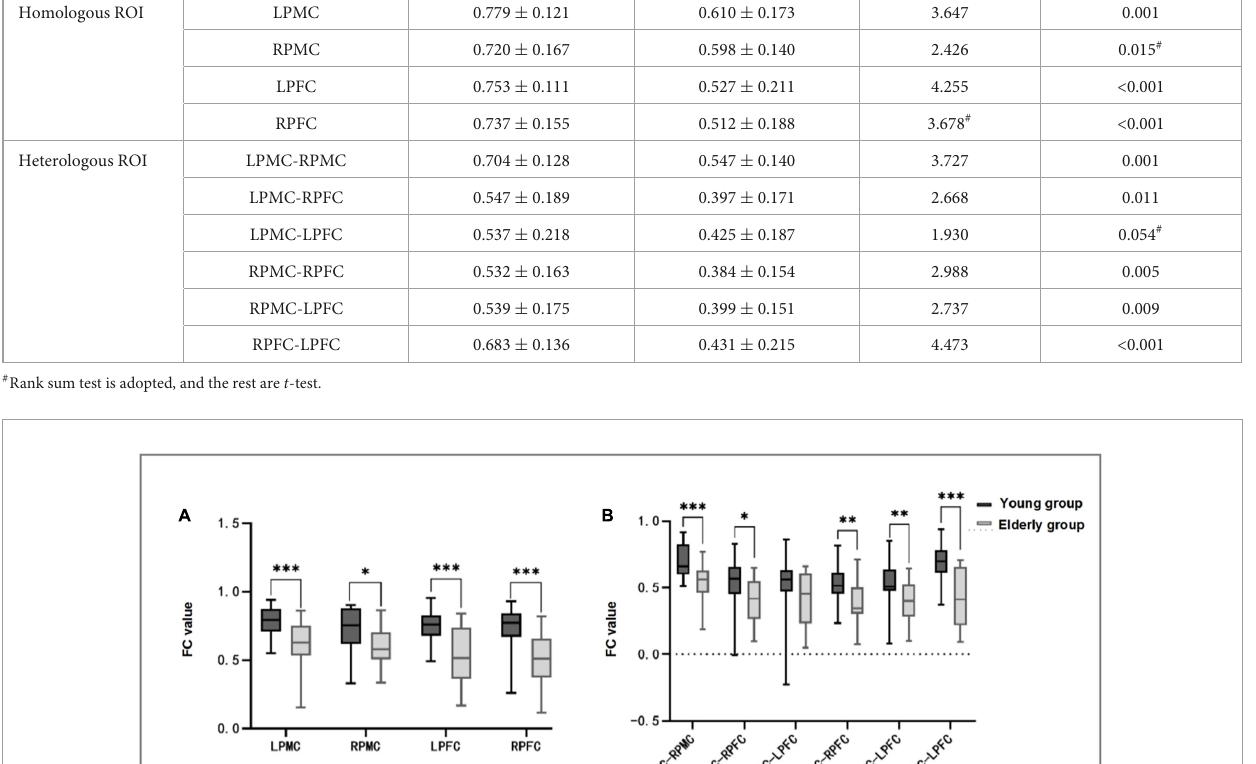
TABLE 3 Comparison of functional connectivity (FC) values of homologous and heterologous brain networks between the two groups in forward judgment test. ROI Young group